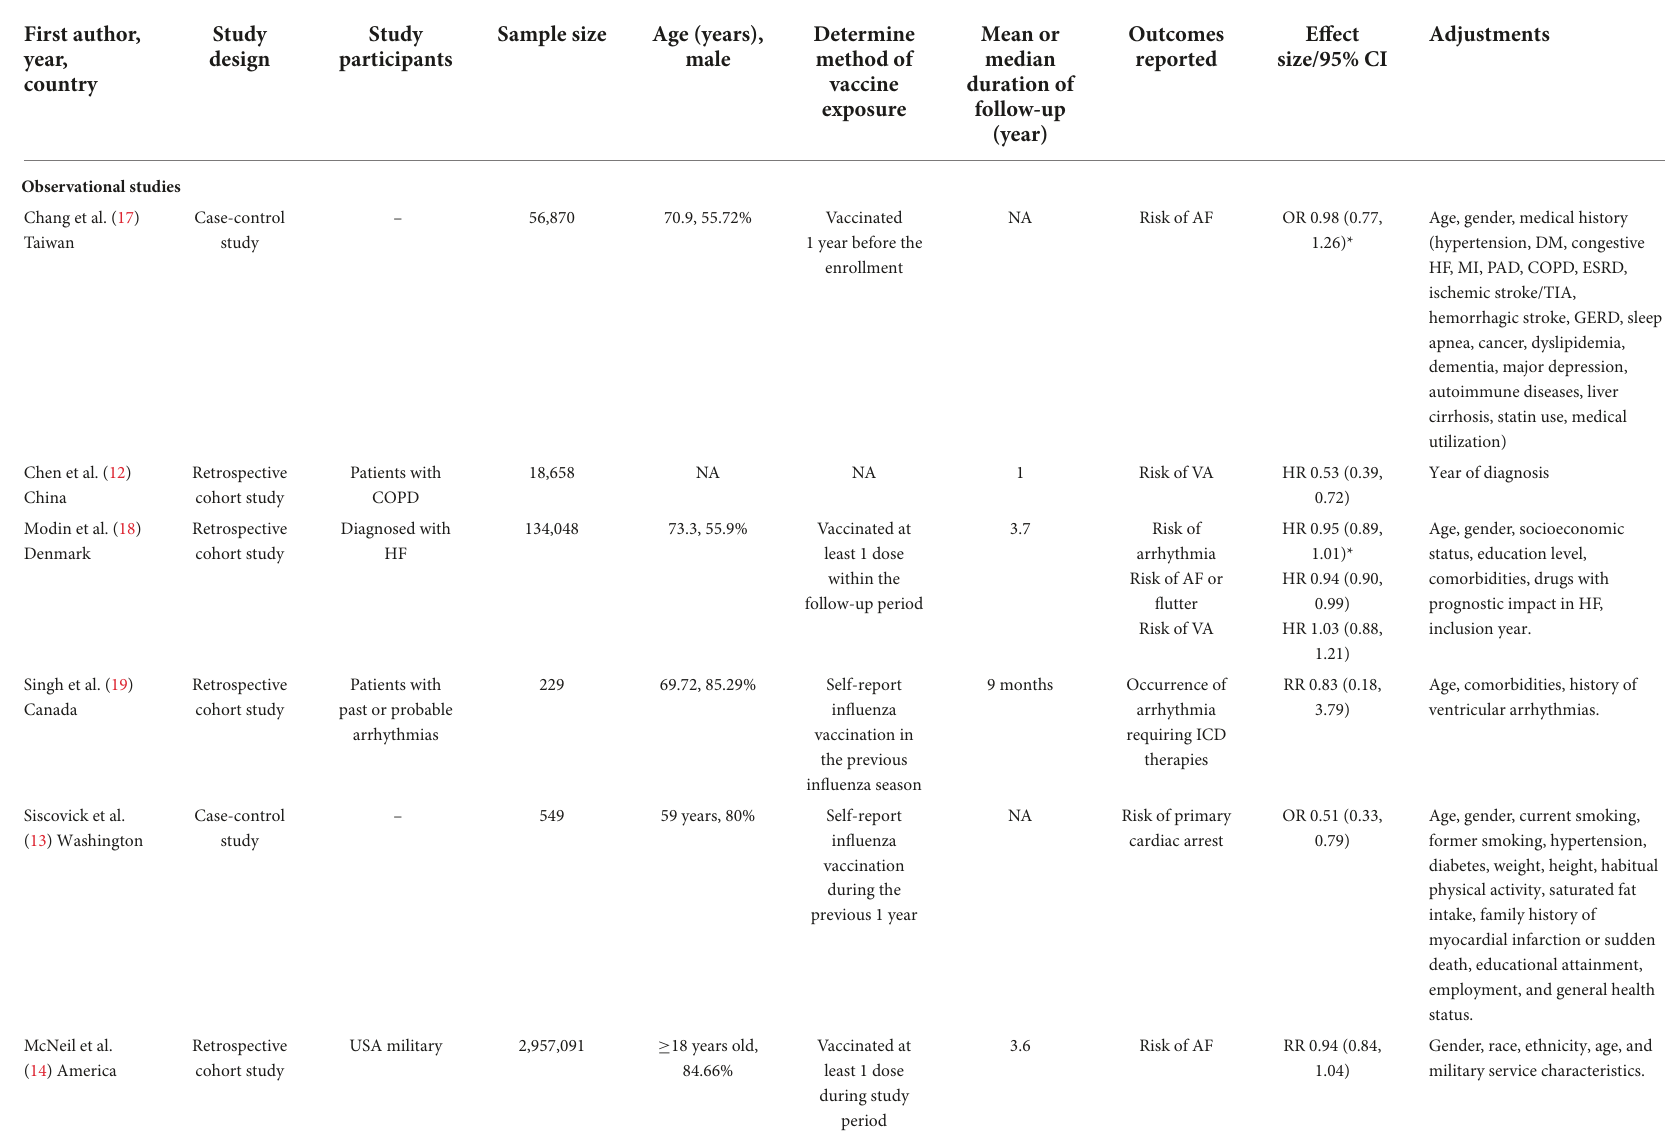
TABLE 1 Characteristics of included studies in this